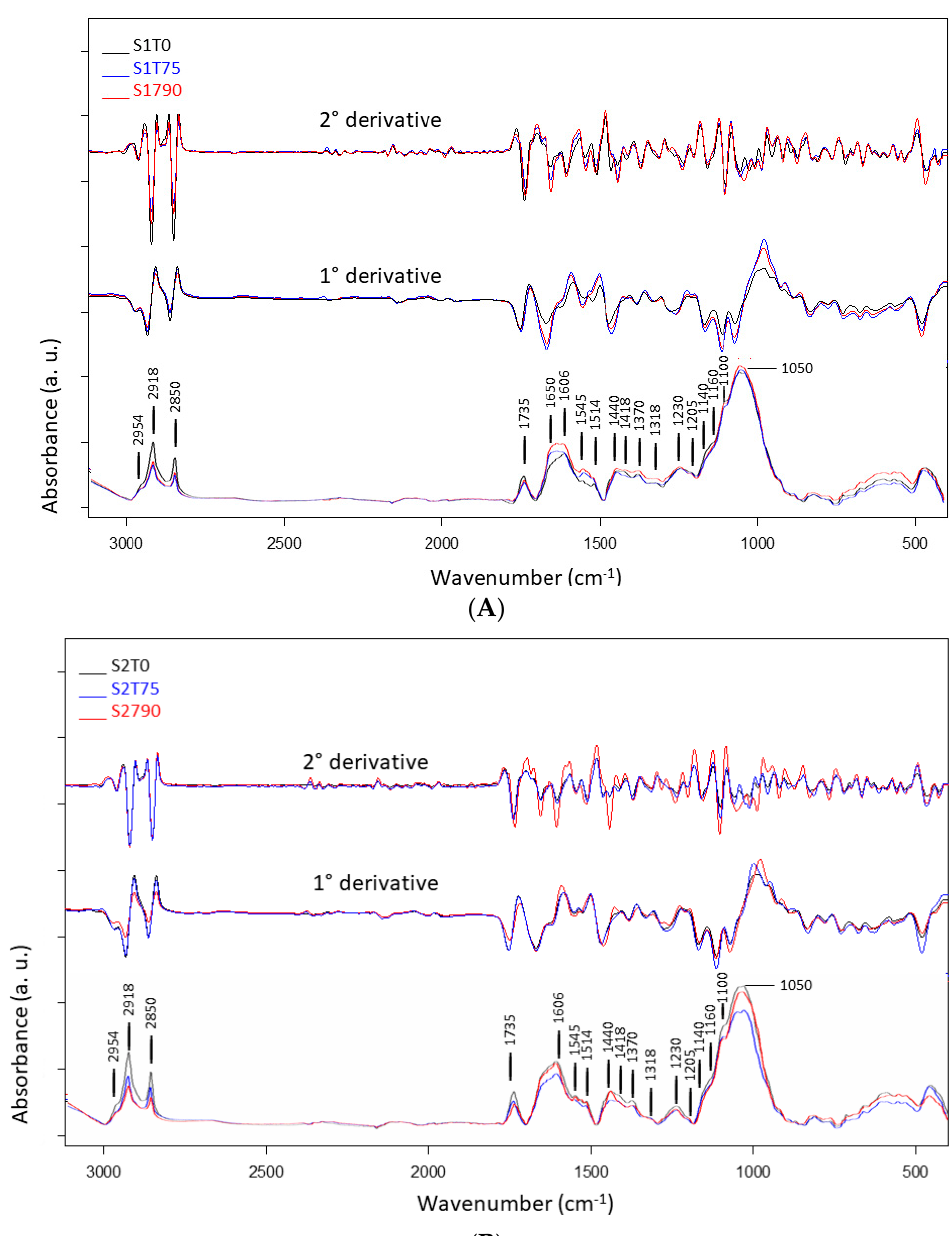
Figure 3. ( A ) FTIR spectra of S1 samples: average (on the bottom), 1 ◦ derivative spectra (in the middle) and 2 ◦ derivative spectra (on the top) at T0 (black), at T75 (blue) and at T90 (red) days. ( B ) FTIR spectra of S2 samples: average (on the bottom), 1 ◦ derivative spectra (in the middle) and 2 ◦ derivative spectra (on the top) at T0 (black), at T75 (blue) and at T90 (red) days.